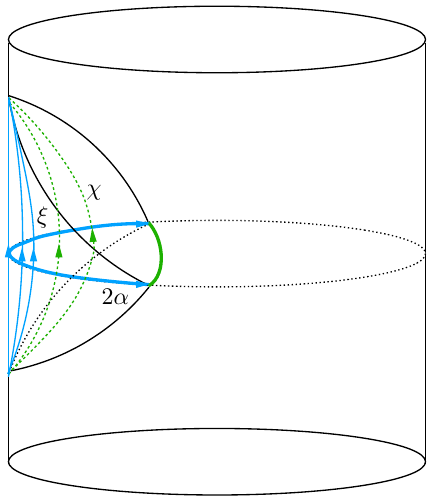
Figure 7 . The Rindler wedge of pure AdS 3 with associated boundary causal diamond (in black). The bifurcation surface (in green) of the AdS-Rindler horizon is the Ryu-Takayanagi surface asso- ciated to the entangling region of angular size 2 α (in blue). The boost Killing vector χ (with flow in green) of AdS-Rindler asymptotes to the conformal Killing vector ξ , which generates a flow (in blue) inside the boundary causal